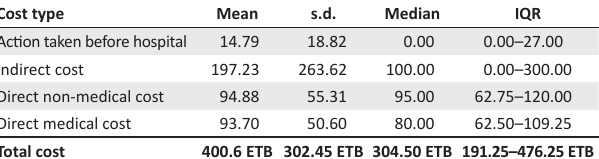
FIGURE 1: Duration of hospitalisation among patients, TABLE 2: Cost associated with community-acquired pneumonia among children (in Ethiopian birr).